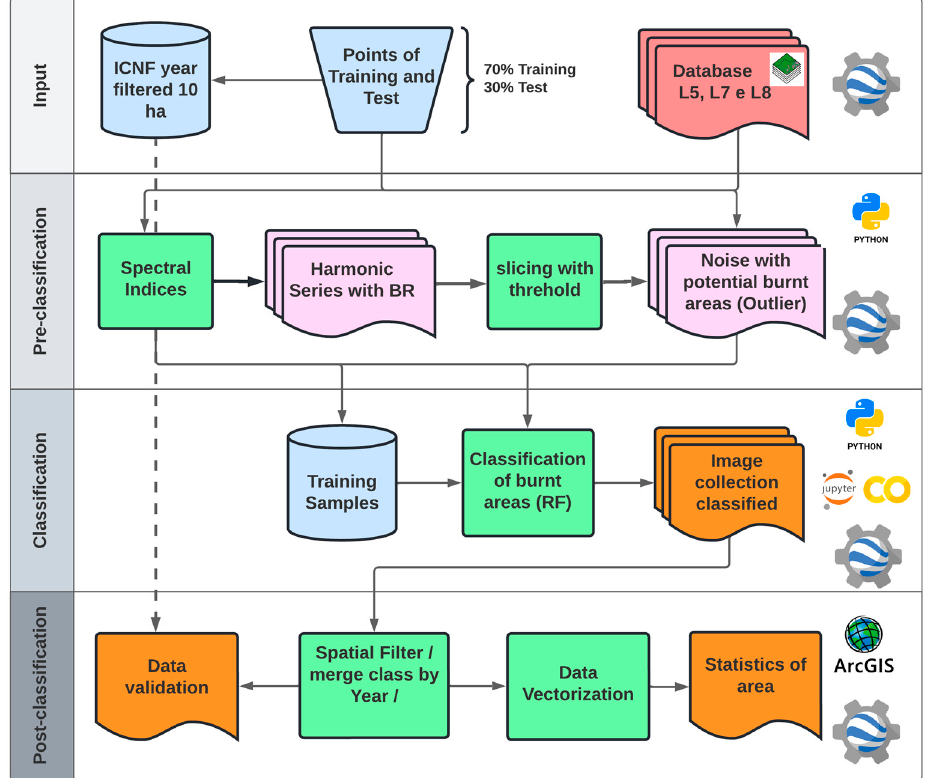
Figure 2. Methodological steps to implement the mapping of large wildfires (in northwestern Portugal) and classification protocol on the Google Earth Engine. The study was organized in 4